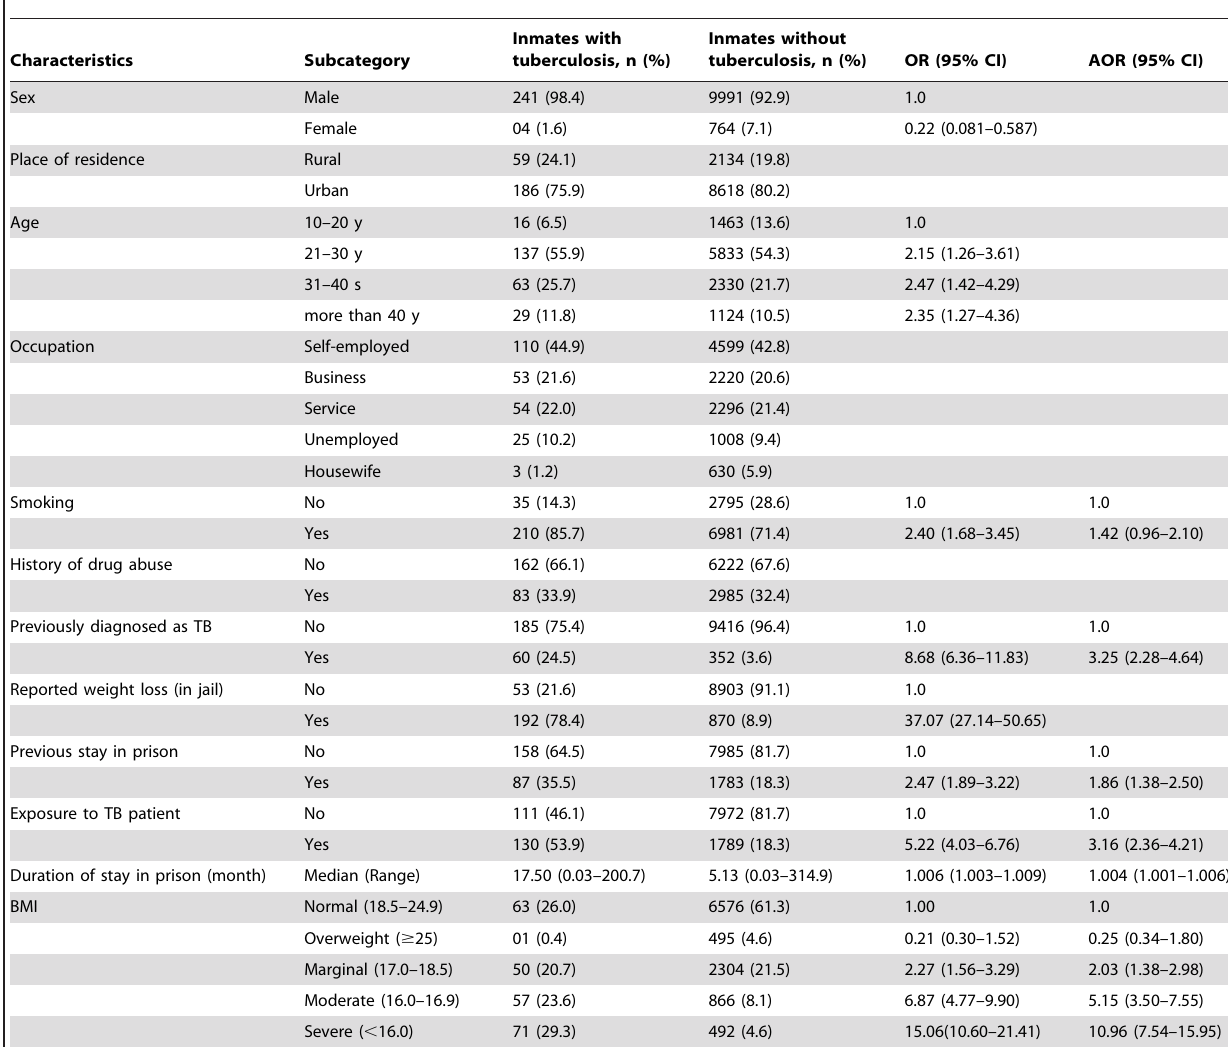
Table 2. Socio demographic characteristics of TB and non-TB cases and odds ratios (95% CI) for risk factors for tuberculosis.